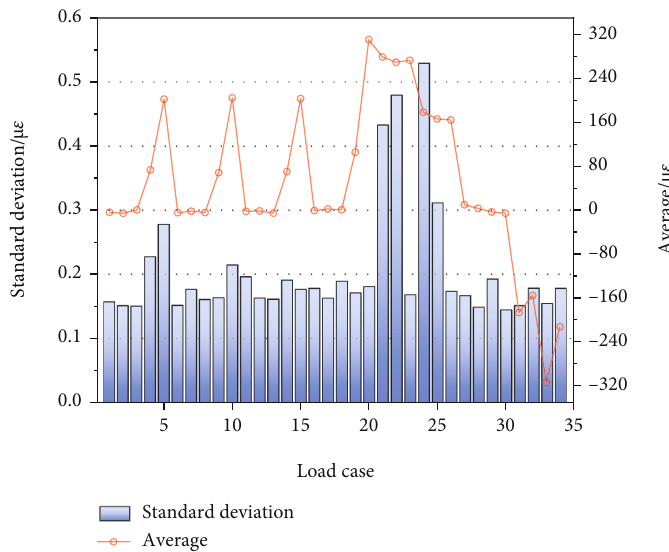
Figure 9: Standard deviation and average of all load cases of one strain